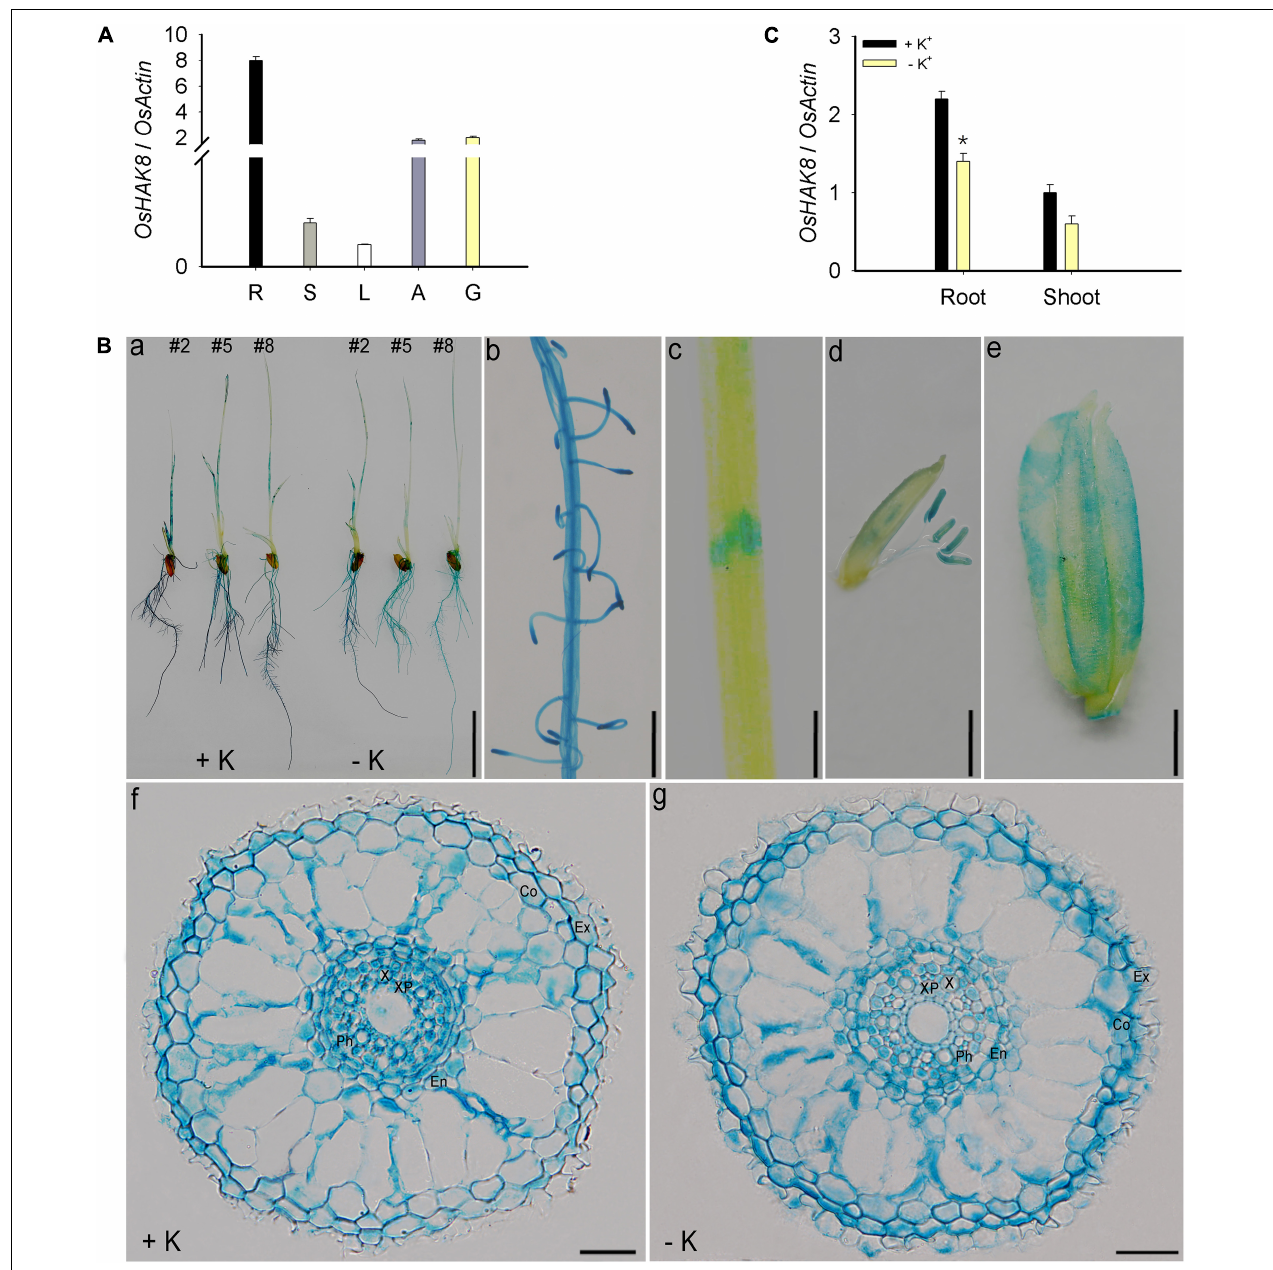
FIGURE 5 | Expression pattern of OsHAK8 . qRT-PCR analyses showing OsHAK8 mRNA accumulation in roots, stems, leaves, anthers, and glumes. Rice seedlings ( Nipponbare ) were grown in soil for 10 weeks. R, root; S, stem; L, leaf; A, anther; G, glume. (A) Histochemical analysis of OsHAK8 promoter-driven GUS reporter expression in transgenic rice plants. The transgenic plants were grown as described in (B) , and GUS activities (indicated in blue) were examined using histochemical staining. (a) GUS staining of 7-days-old plants (Line 2) grown in hydroponic solutions with 10-mM K + (+ K) or 0-mM K + (-K). (b) Enlarged image of the root hair zones in (a). (c) Enlarged image of the node in (a). (d) GUS staining of anthers. The transgenic plants were grown as described in (A) . (e) GUS staining of glume. The transgenic plants were grown as described in (A) . (f,g) Cross-section images of the elongation zone in (a). Ex, exodermis; Co, cortex; En, endodermis; Ph, phloem; X, xylem; XP, xylem parenchyma. Bar in (a) = 1 cm, bar in (b) = 5 mm, bar in (c) = 1 mm, bar in (d) = 1 mm, bar in (e) = 1 mm, and bars in (f) to (g) = 100 µ m. (C) Effect of K + deficiency on the transcriptional expression of OsHAK8 in rice. 3-day-old rice seedlings ( Nipponbare ) were grown in a hydroponic solution containing 10 mM K + for 3 days and then transferred to 10-mM K + (+ K) and 0-mM K + ( − K) solutions for 24 h, respectively. Total RNAs were isolated from the roots and shoot of the seedlings, and OsHAK8 transcript levels were determined by qRT-PCR. Actin was used as an internal standard. Significant difference was found between 0- and 10-mM K + samples indicated in root tissue ( P <0.01 by Student’s t -test). Data are means of three replicates of one experiment. The experiment was repeated three times with similar results. Error bars represent ± SD. Asterisks represent significant